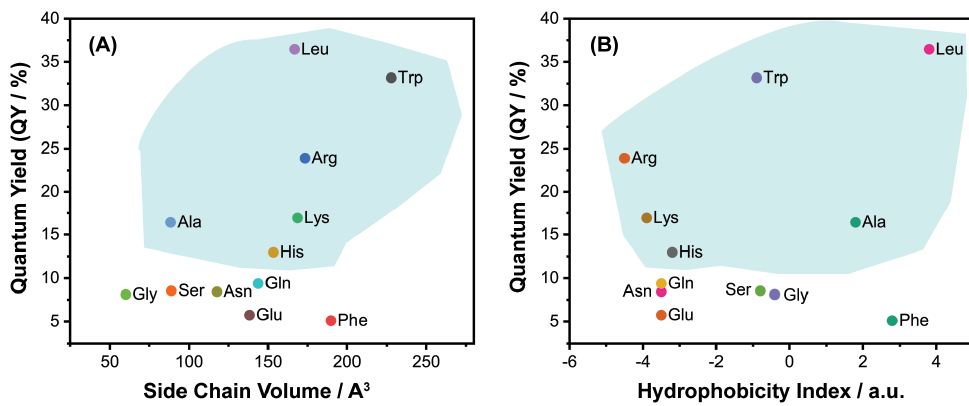
Figure 1. The effects of chemical characteristics of amino acids on the determined QY: ( A ) the effects of side chain volume and ( B ) the hydrophobicity index. The selected samples of CQDs were marked with blue shadow.